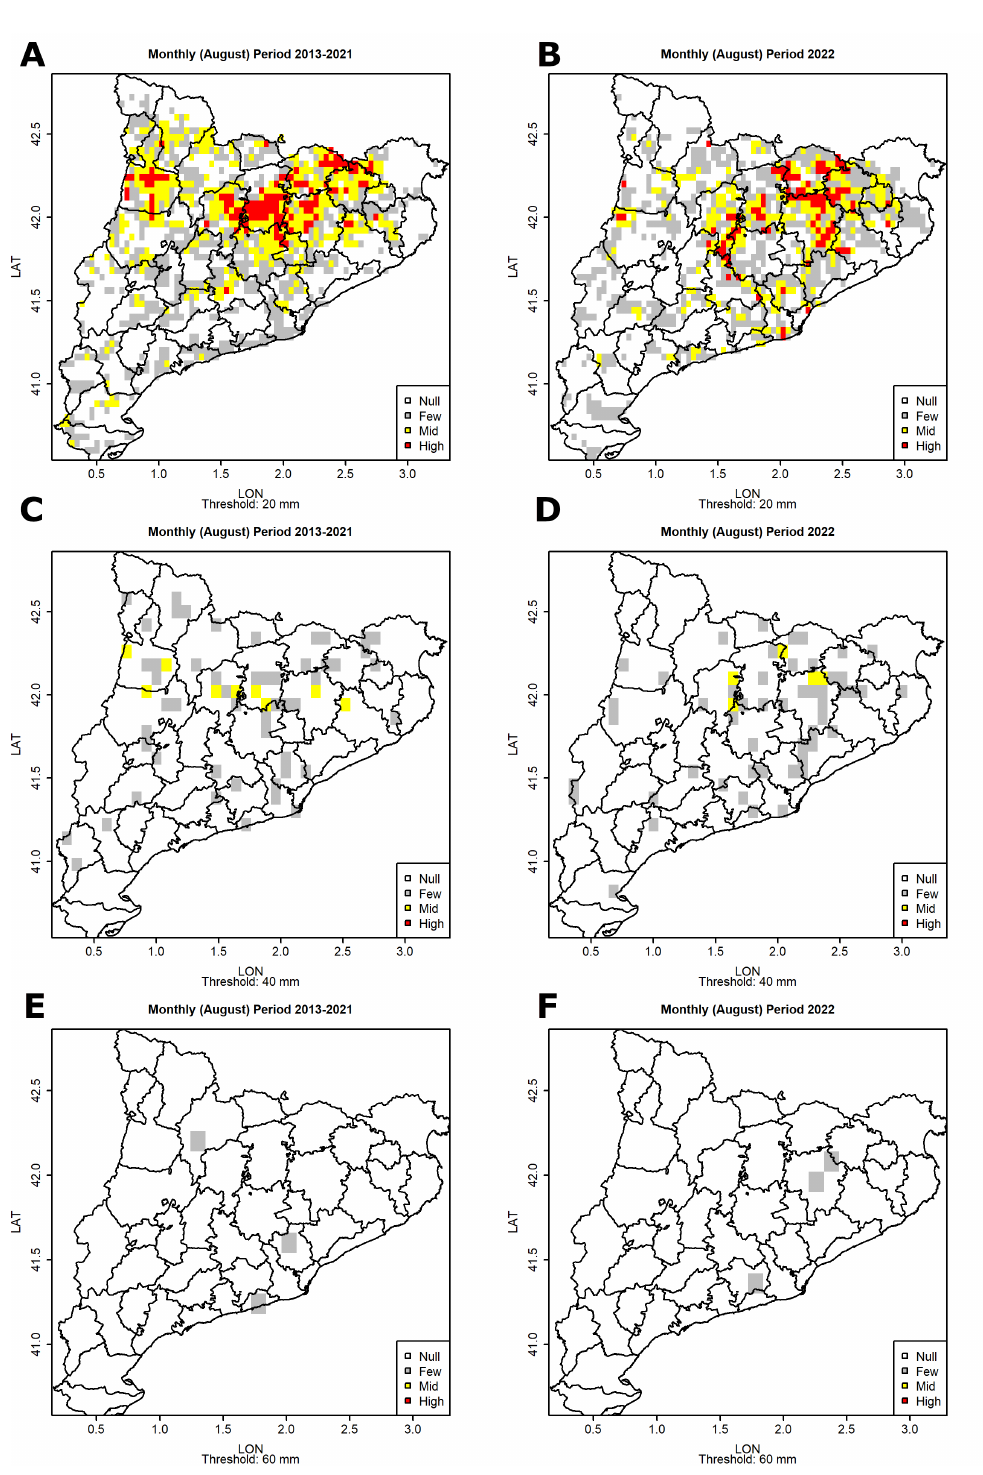
Figure 7. ( A – F ) Same as Figure 4, but for the August monthly